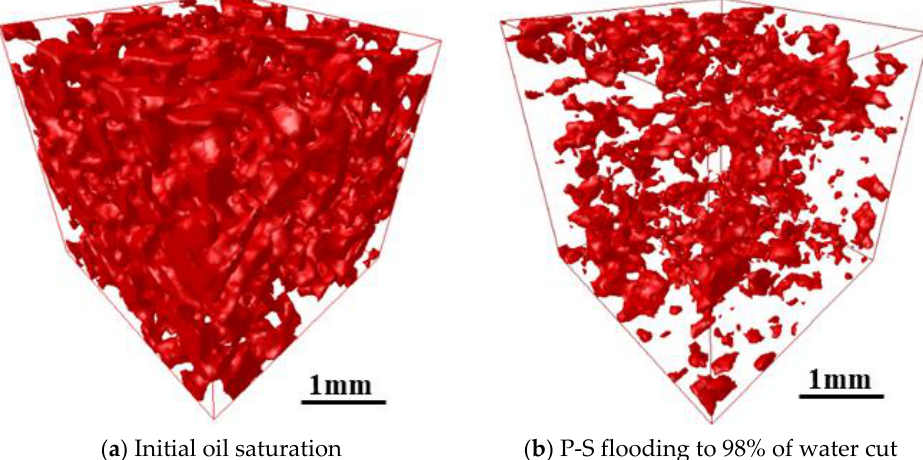
Figure 11. Three-dimensional visualization of oil droplet after P-S flooding in the No. 2 rock sample.